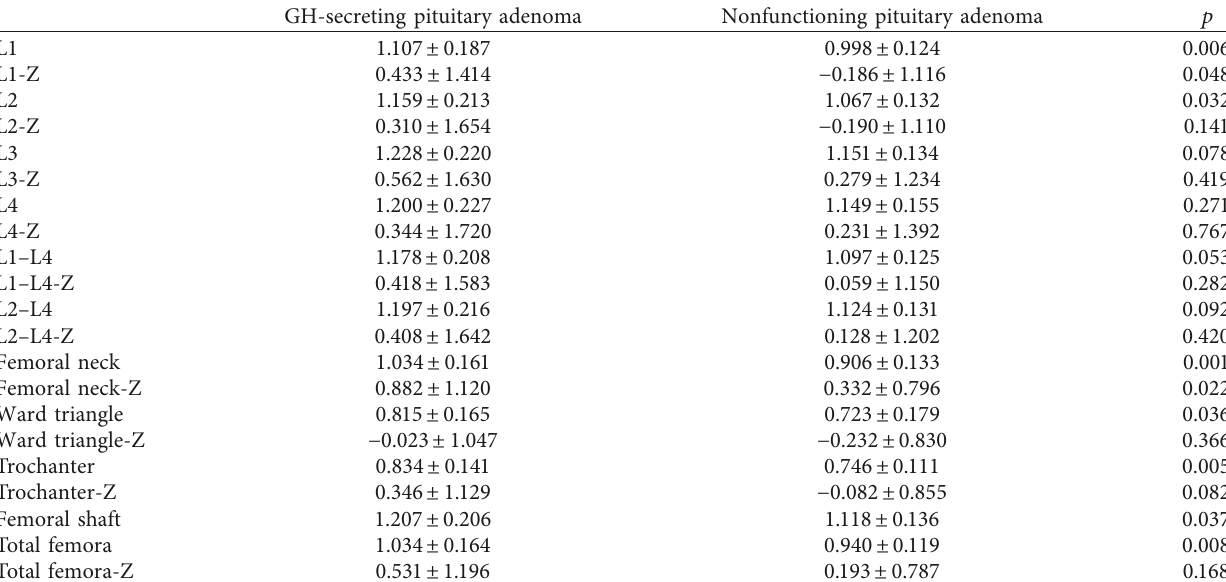
Table 2: BMD of the GH-secreting pituitary adenoma group and the nonfunctioning adenoma group. GH-secreting pituitary adenoma Nonfunctioning pituitary